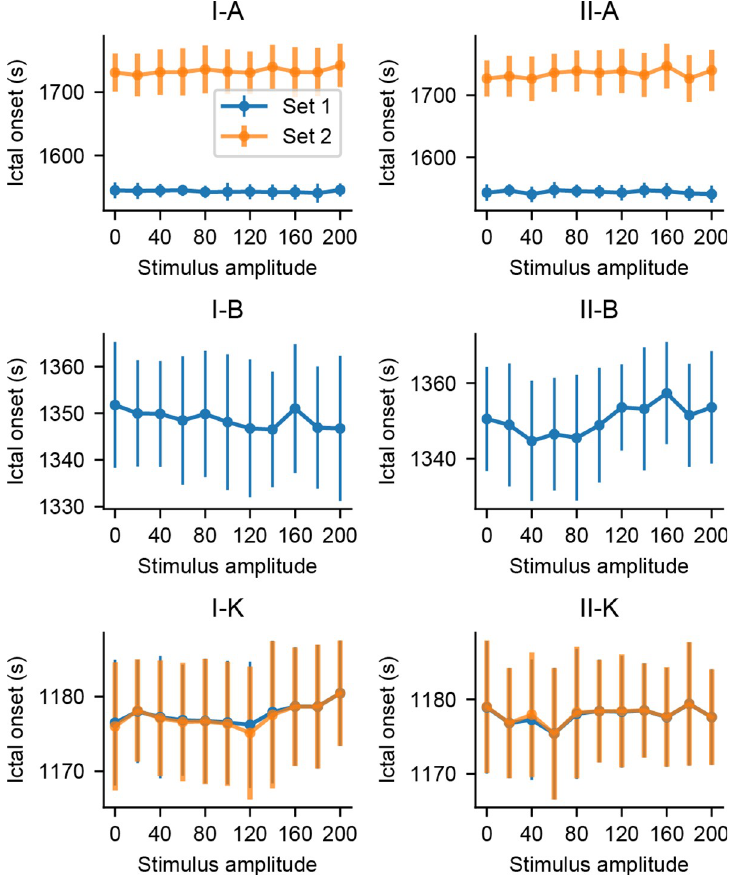
Fig 9. Onset time of ictal-like activity as a function of stimulus amplitude. Simulations with increased amplitudes did not affect the onset latencies of sustained spike discharges in any model setting.